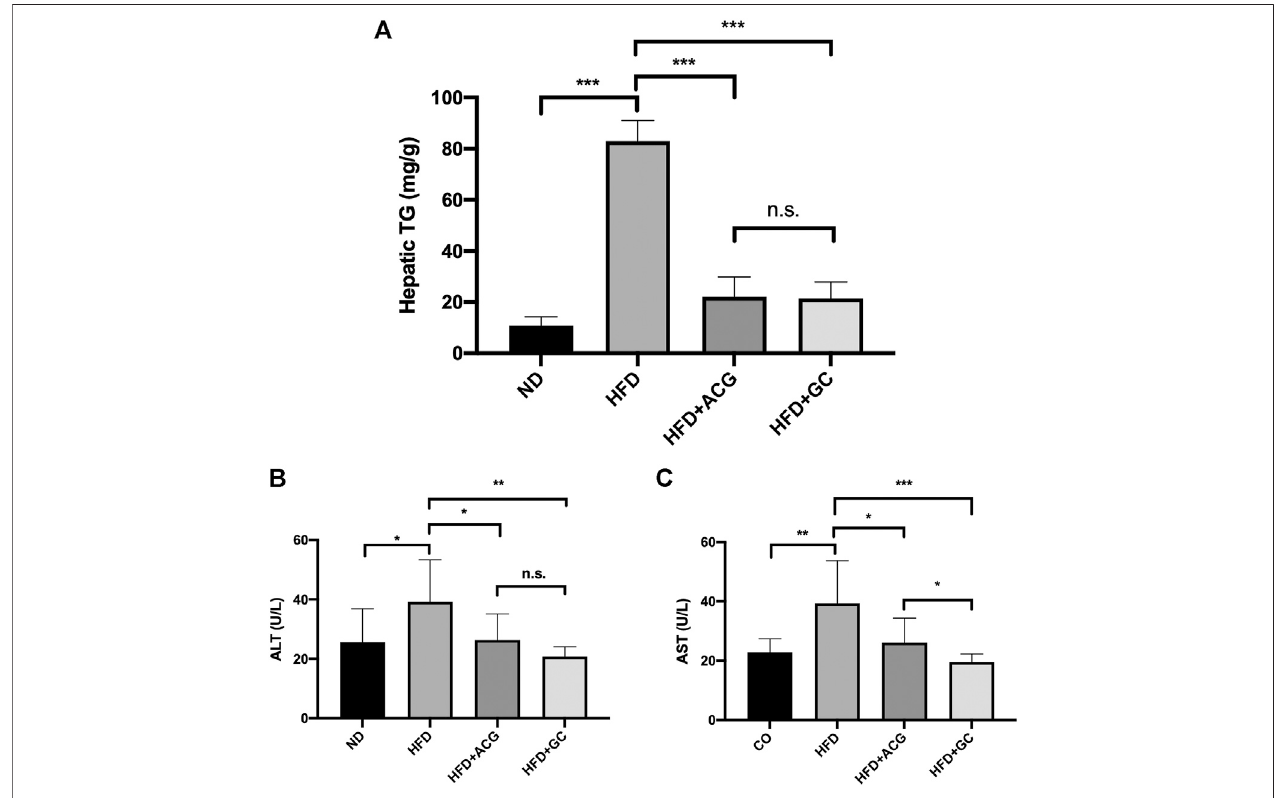
FIGURE 1 | The GC combination ameliorates the hepatic triglyceride (TG) accumulation and impairs the elevated alanine aminotransferase (ALT) and aspartate transaminase (AST) levels in NAFL rats. (A) Hepatic TG content in rats ( n (cid:1) 9) (B,C) serum ALT and AST ( n (cid:1) 9). * p < 0.05, ** p < 0.01, *** p < 0.001, n.s. (cid:1) no signi fi cant.